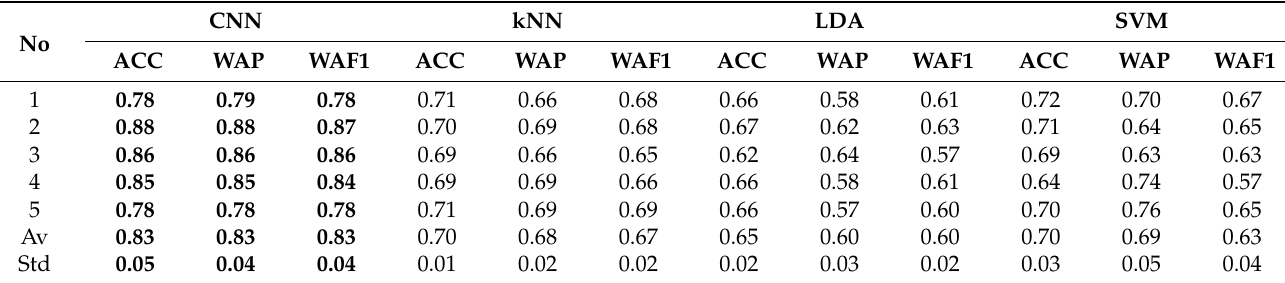
Table 11. Cross validation test results for the voice